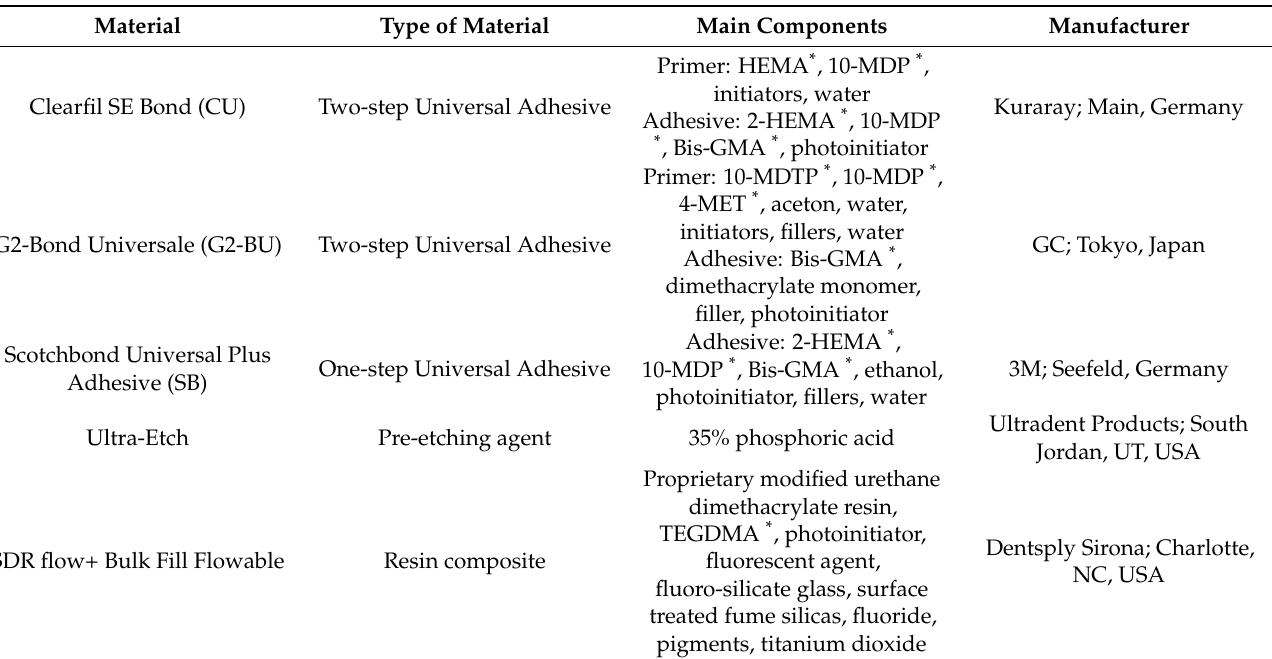
Table 1. The study’s